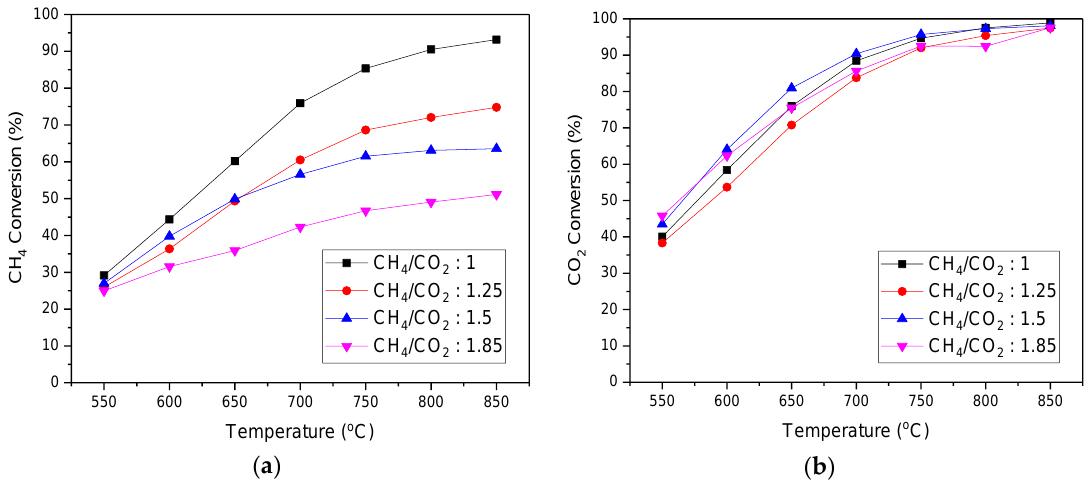
Figure 5. Catalytic performance of Ni-Sn/CeAl at CH 4 /CO 2 molar ratios of 1, 1.25, 1.5 and 1.85 as a function of temperature: ( a ) methane conversion; ( b ) carbon dioxide conversion.